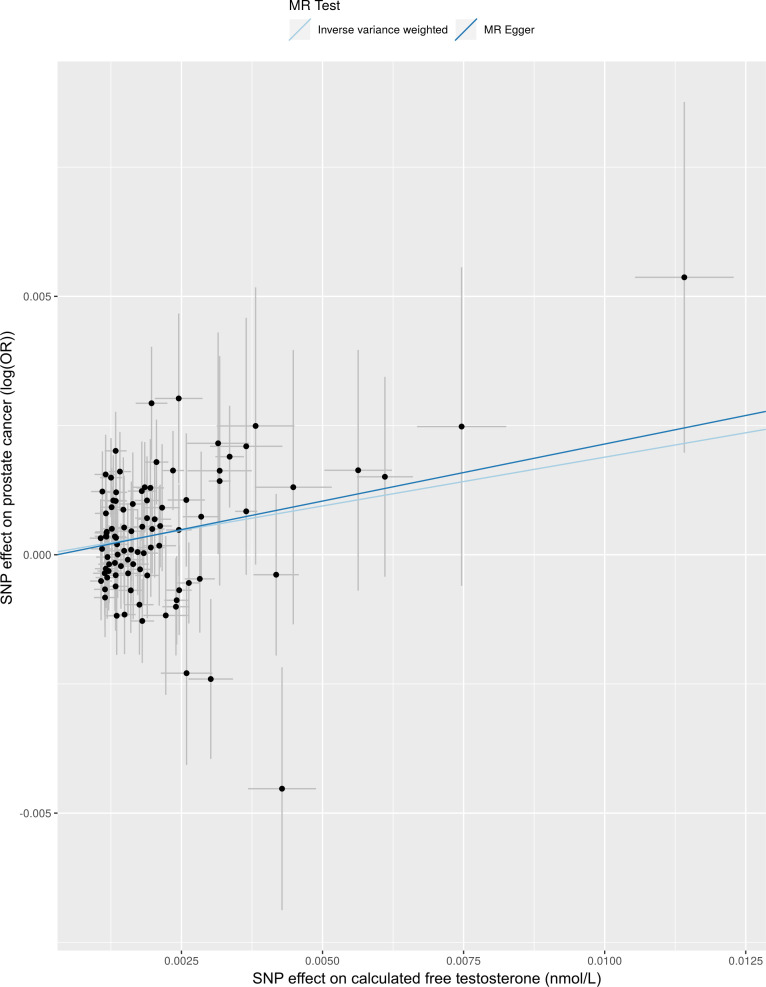
Comparison of effect of calculated free testosterone on prostate cancer using Mendelian randomization with IVW and Egger regression methods.